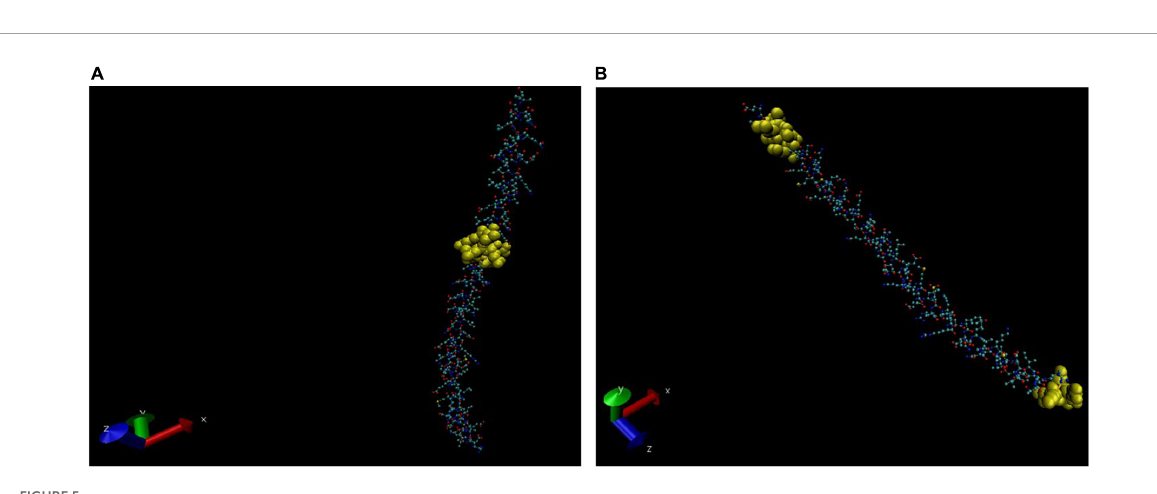
FIGURE5 Three-dimensional (3D) structure of Vimentin (partial). The BCEs are highlighted in yellow (A,B) .